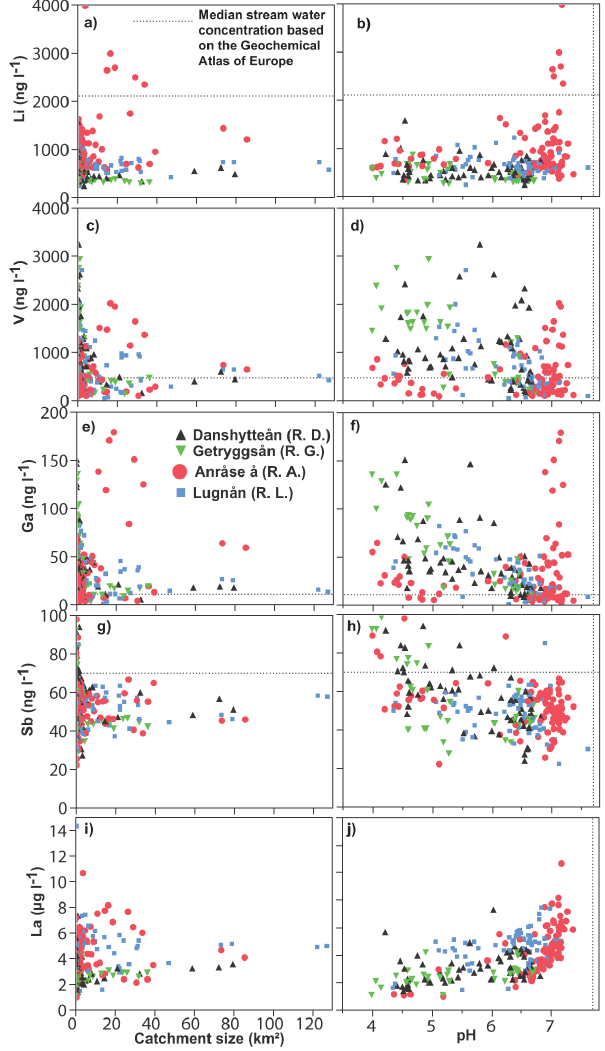
Fig. 4. Chemistry variation with catchment size (left panel) and pH (right panel) for several trace elements; (a–b) Li, (c–d) V, (e–f) Ga, (g–h) Sb and (i–j) La. River Anr˚ase ˚a is represented by red dots, River Lugn˚an by blue squares, River Danshytte˚an by black trian- gles (pointed up) and River Getryggs˚an by green triangles (pointed down). Dashed lines are median stream water concentrations and pH according to the Geochemical Atlas of Europe (Salminen et al., 2005). For La the European value, 0.034µgL − 1 , is too low to be seen on the